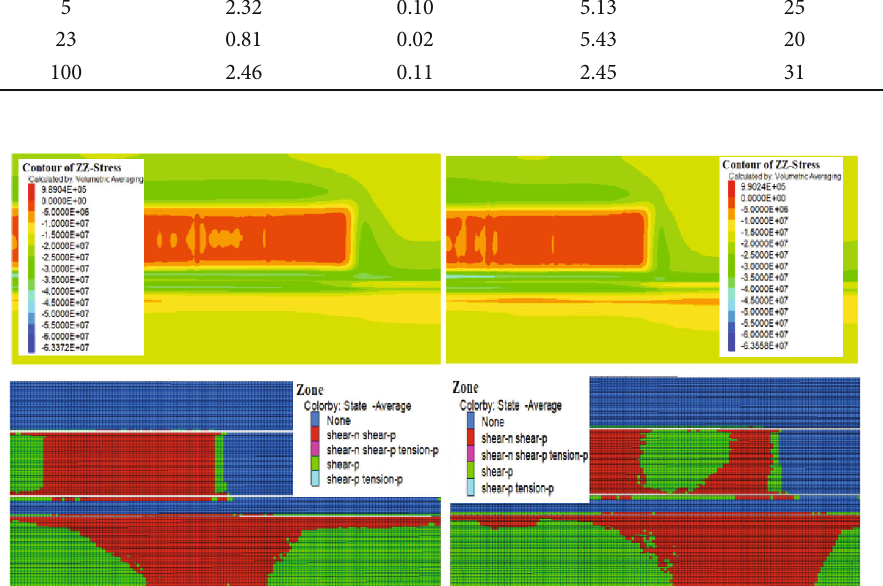
Figure 8: Evolution characteristics of the static stress and rock damage.